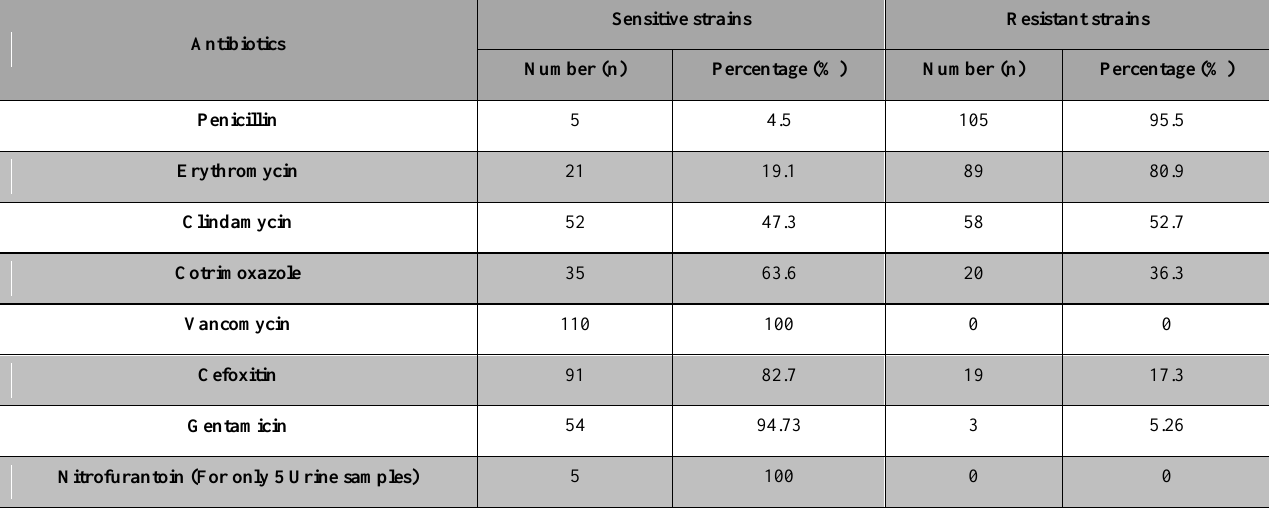
Table 5. Antibiotic susceptibility testing pattern of the isolated CoNS strains.